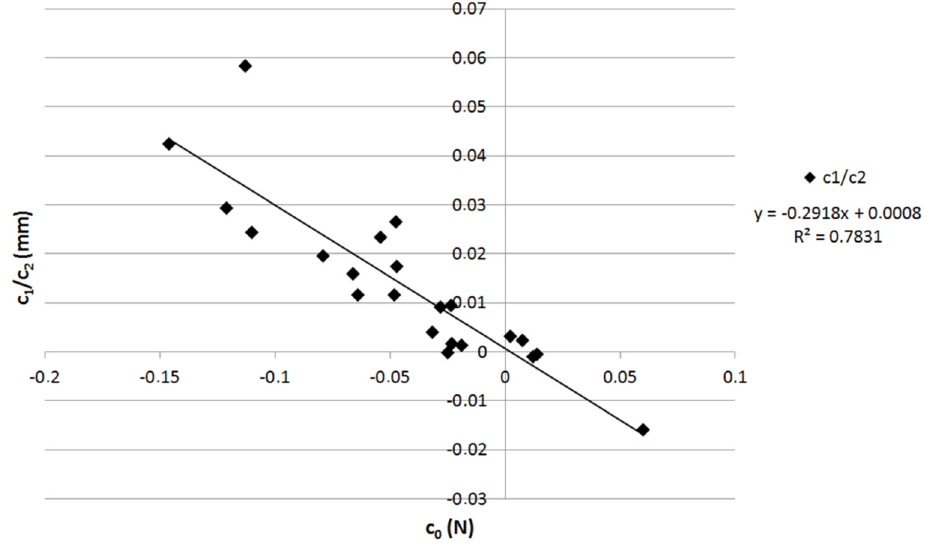
Figure 11. The relationship between c 0 and c 1 /c 2 .